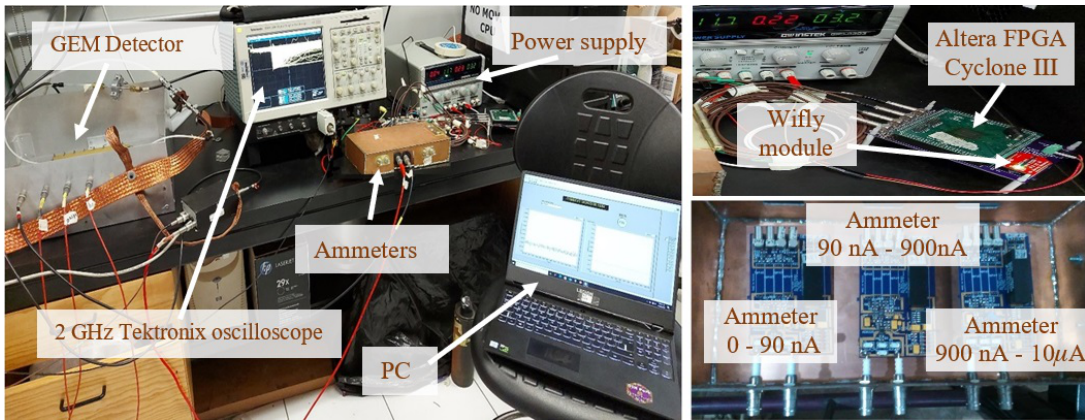
Figure 8. Experimental setup with the current monitoring system connected to the Gas Electron Multiplier (GEM).